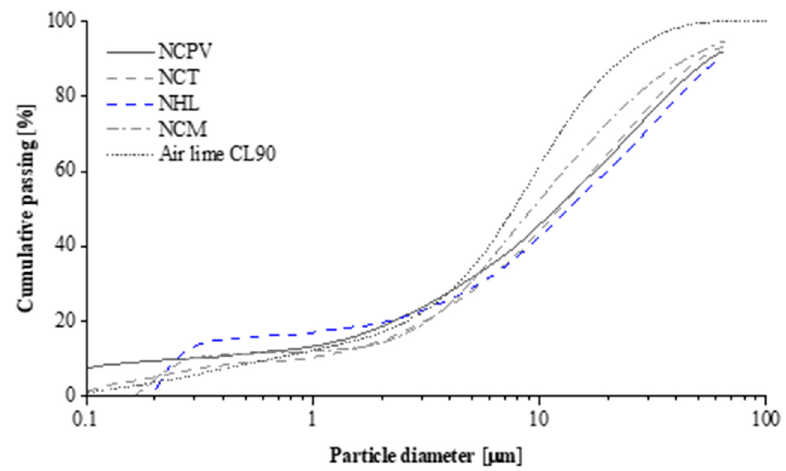
Figure 1. Particle size distribution of the binders. Table 1. Mix proportions and water requirements.